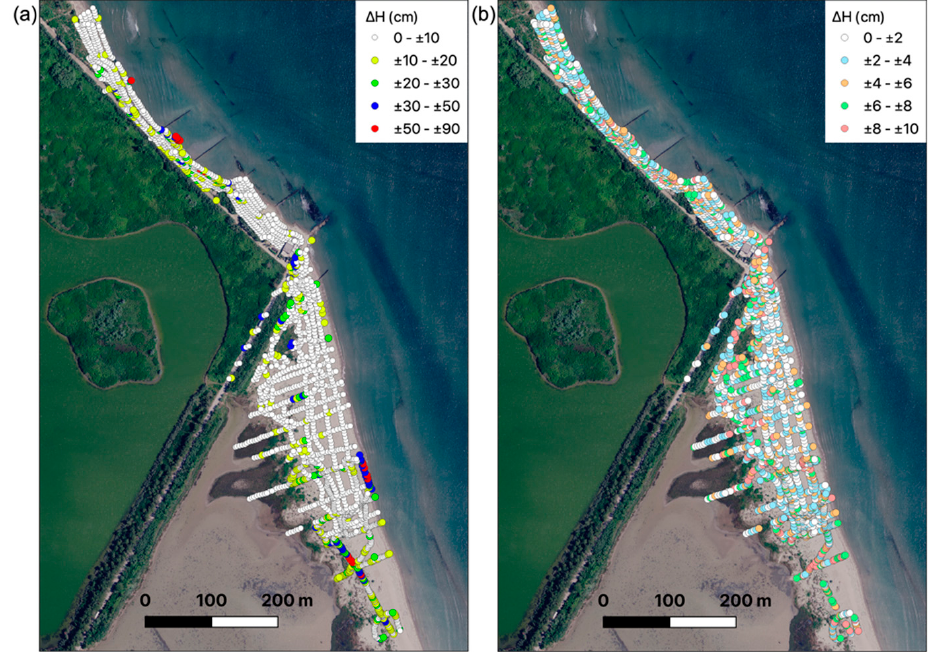
Figure 2. GNSS-acquired points and related height differences between RTK and photogrammetric UAV surveys for the 2019 campaign. ( a ) relates to all the values emphasizing the higher discrepancies; ( b ) relates to differences within 10 cm.